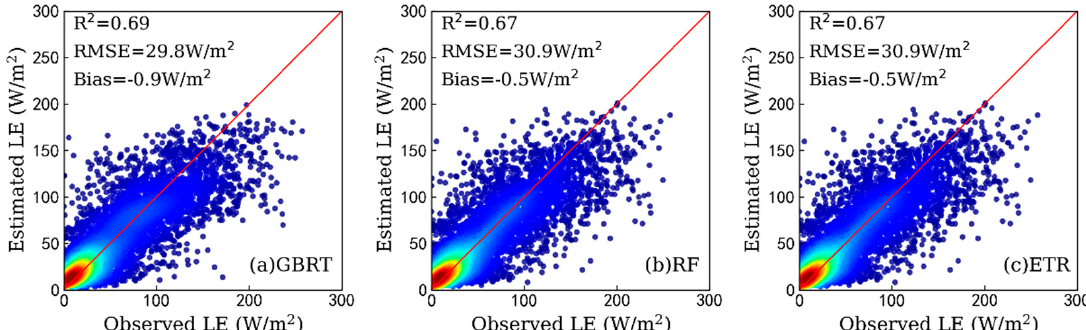
Figure 5. The performance indices result of the testing data of the second cross-validation experiment (one site was tested, and the others site were trained) for the three algorithms. ( a ): GBRT; ( b ): RF; ( c ): ETR.